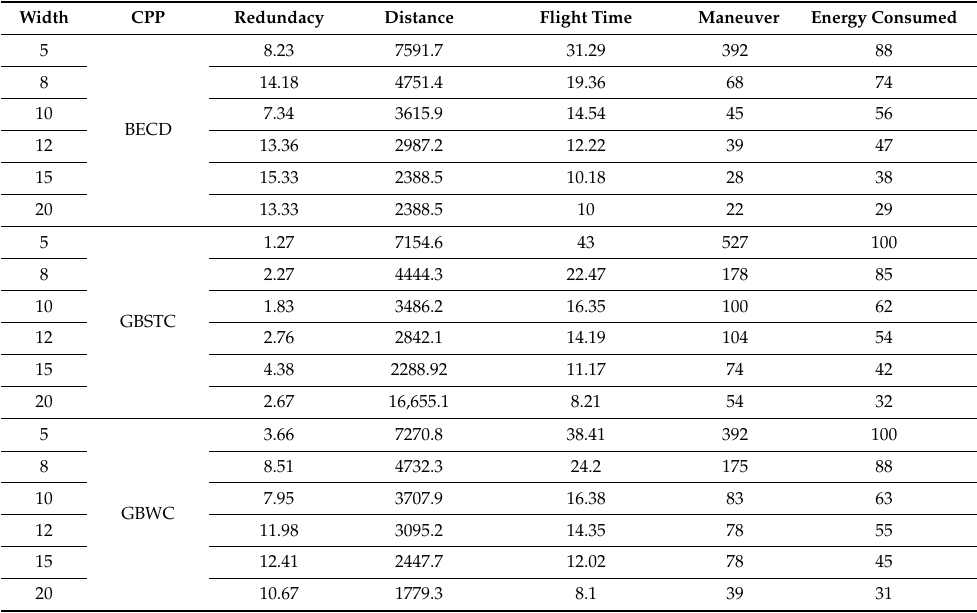
Table A2. Experiment 1 with three CPP methods implemented using Typhoon UAV over Unioeste 1 PV Plant.